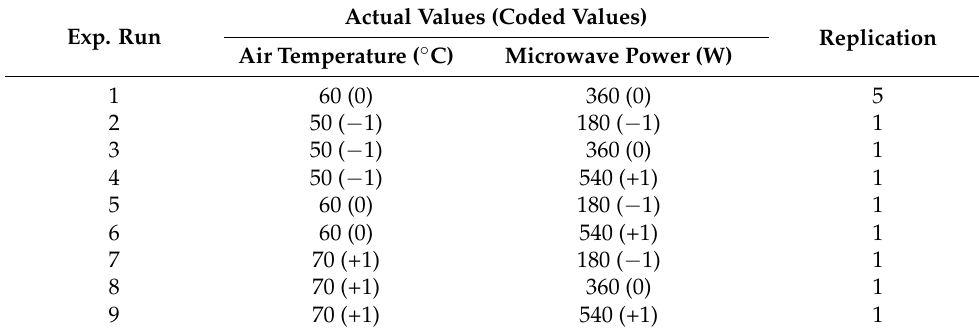
Table 2. Face-centered central composite design of pumpkin slice drying experiments in an MCD